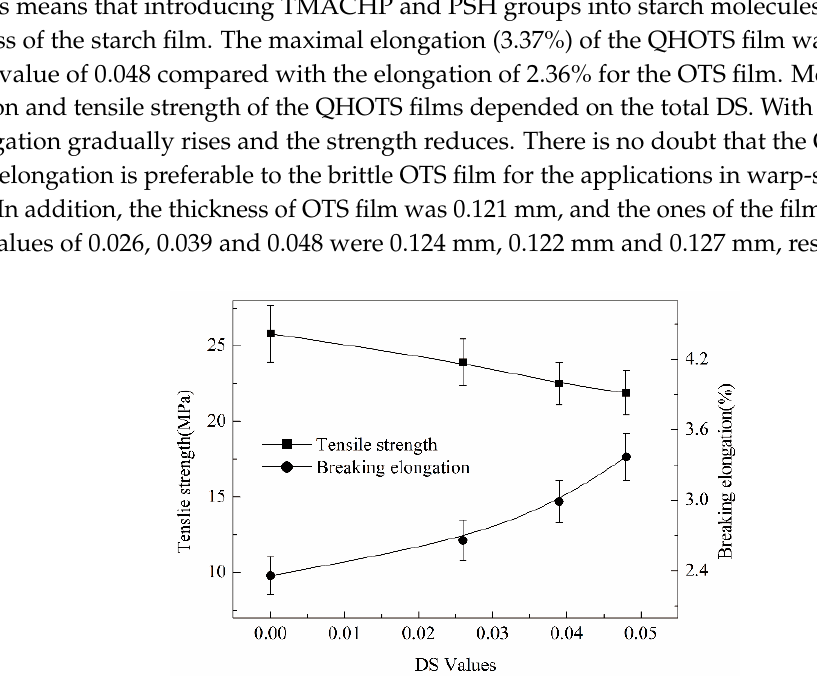
Figure 7. X-ray diffractograms of QHOTS film (a) and OTS one (b). In addition, the hydrophilic groups introduced into the starch molecules can absorb water in the air. Water plays an important role in the tensile properties of starch film since it is an effective plasticizer for diminishing the brittleness of starch film [48,49]. Moisture regains of QHOTS films are determined as a function of their DS values, as represented in Figure 8. It could be found that the two groups evidently increased the regain of starch film, and the regain of QHOTS films was obviously more than that of the OTS one. This means that the groups introduced by starch quaternization/hydroxypropylsulfonation are capable of obviously increasing the regain of the film through absorbing water in air. The regain was correlated with the DS values, and it gradually